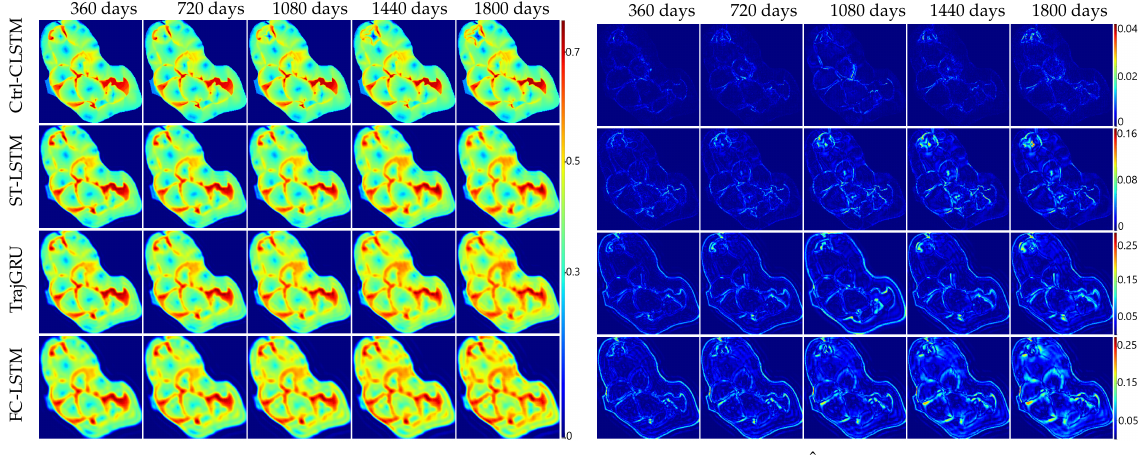
Figure 5. Prediction examples on different